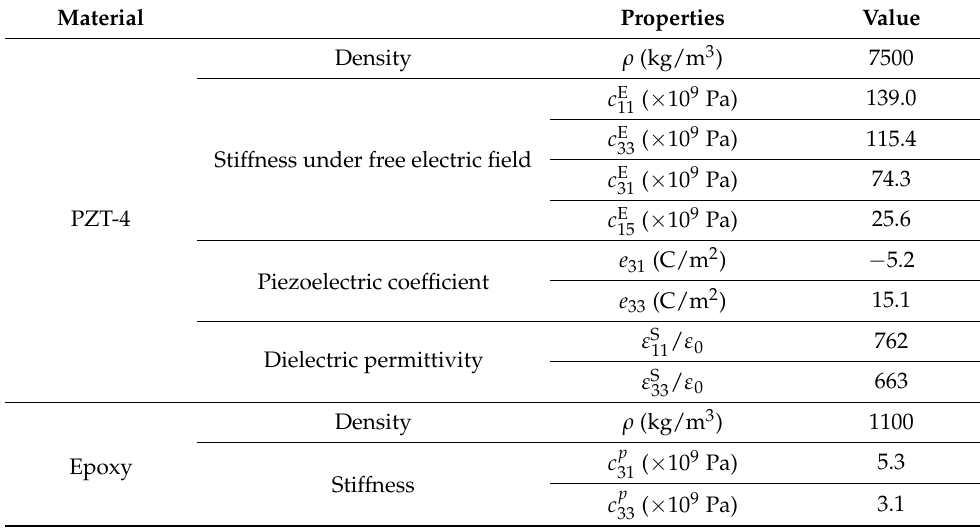
Figure 4. Design procedure of the miniaturized, 1–3 piezoelectric composite, focused ultrasound transducer.